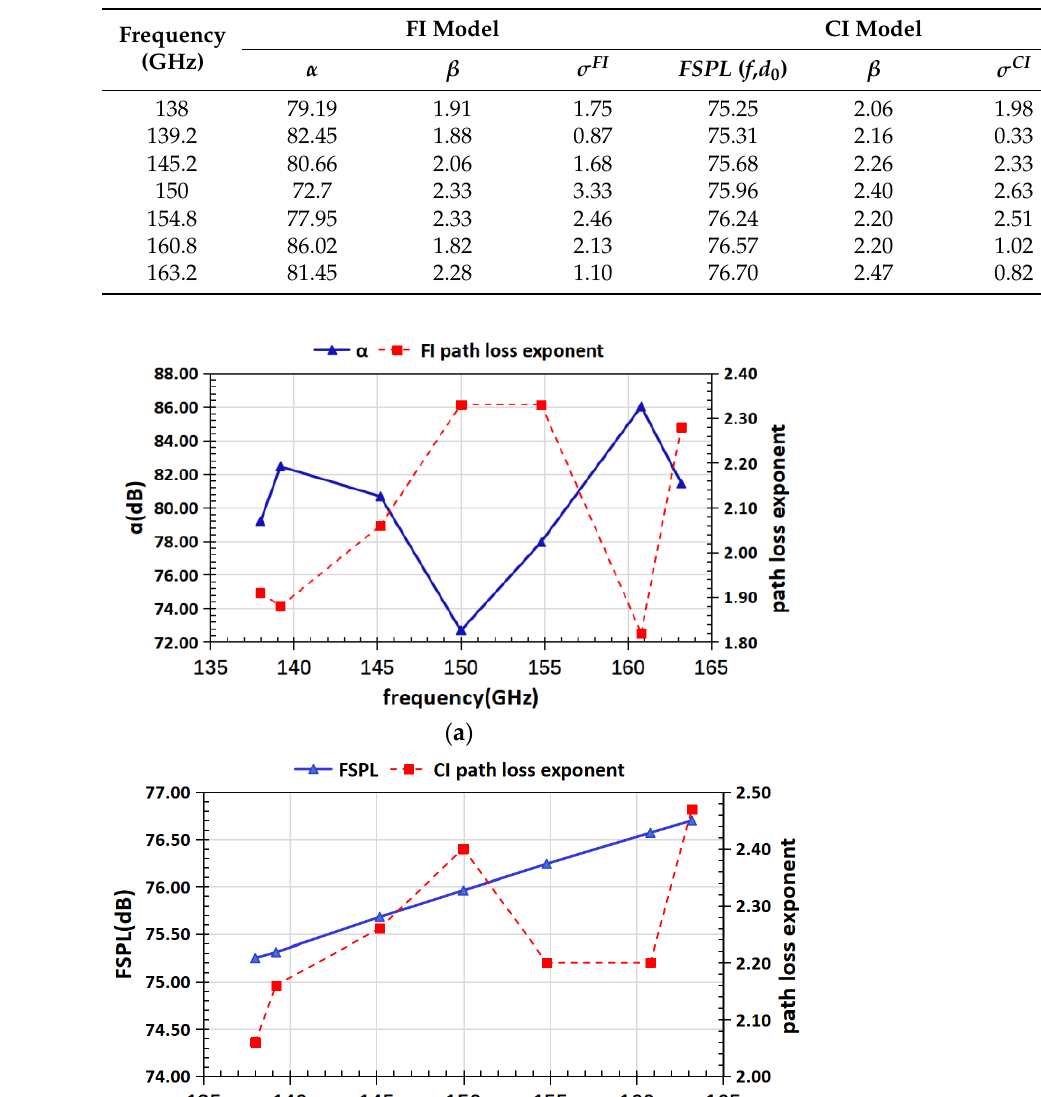
Figure 6. Path loss at distances of 400m and 800m. Table 3. Path loss model parameters.